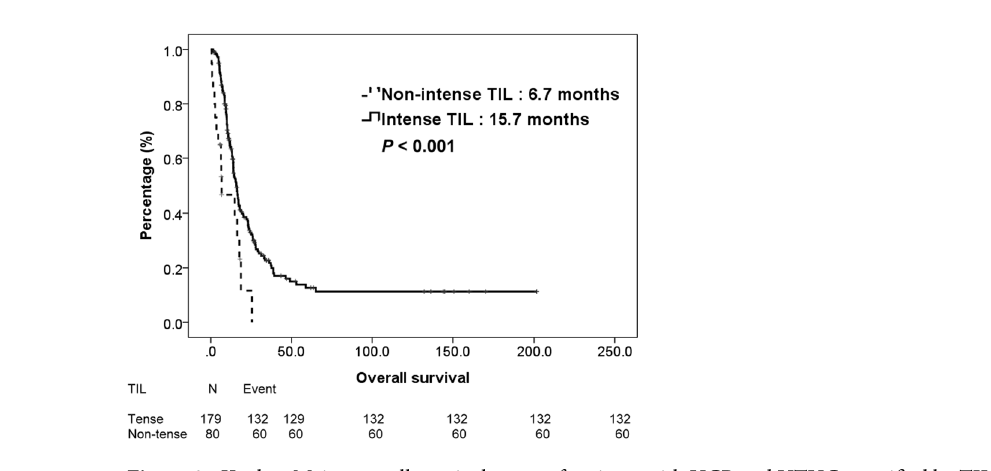
Figure 2. Kaplan-Meier overall survival curve of patients with UCB and UTUC, stratified by